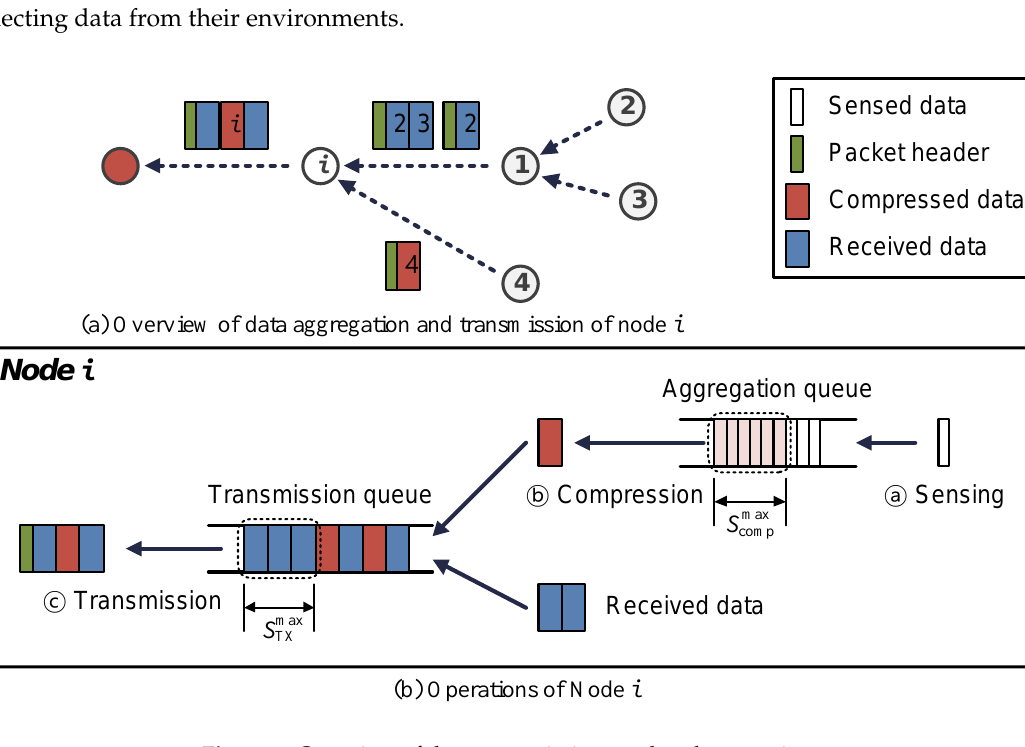
Figure 1. Overview of data transmissions and node